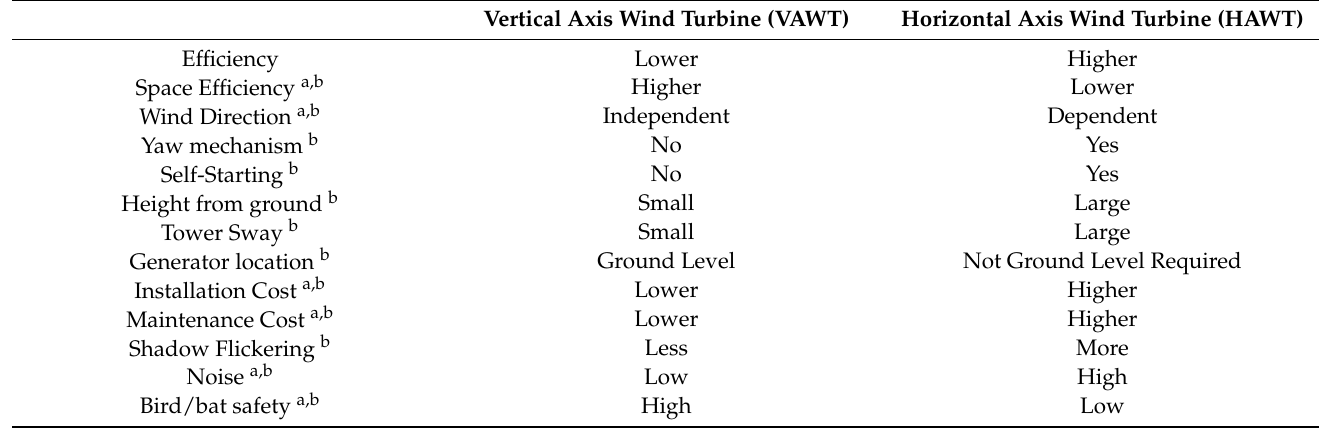
Table 1. Comparison of Parameters between VAWT and